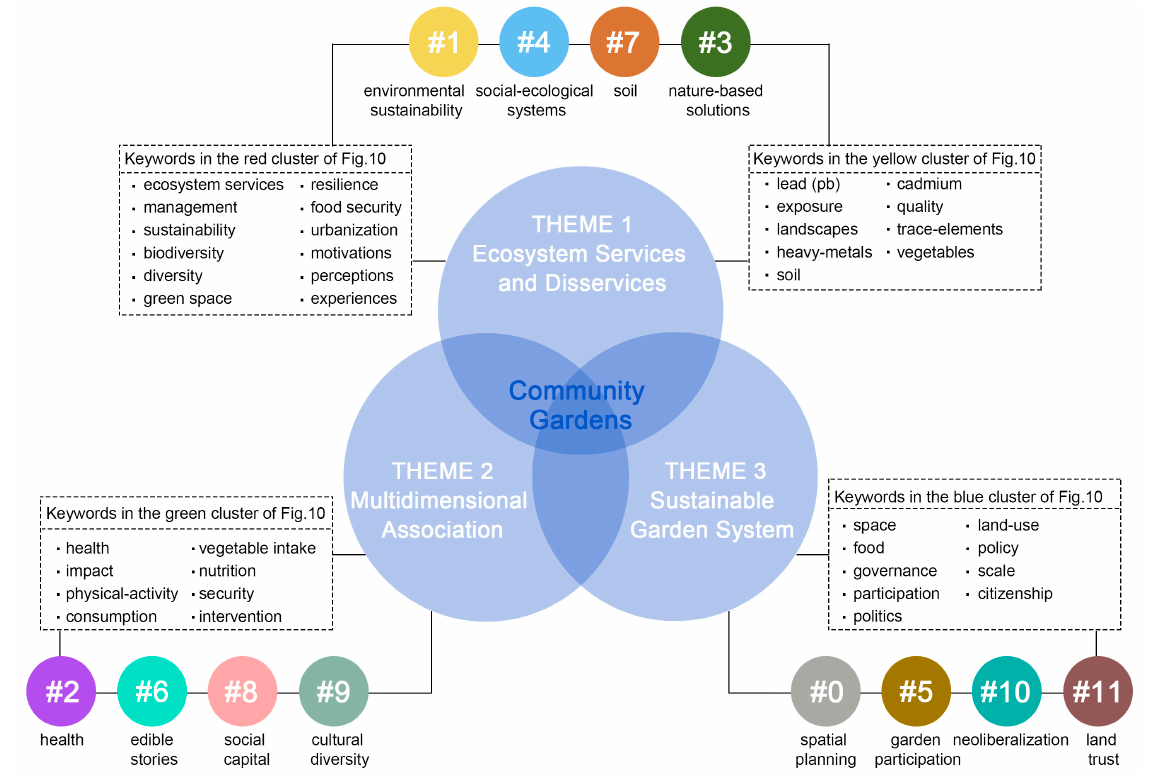
Figure 11. Three themes of urban community gardens: “# number word (s)” represents the cluster in Figure 8, and the cluster’s label is marked directly below.